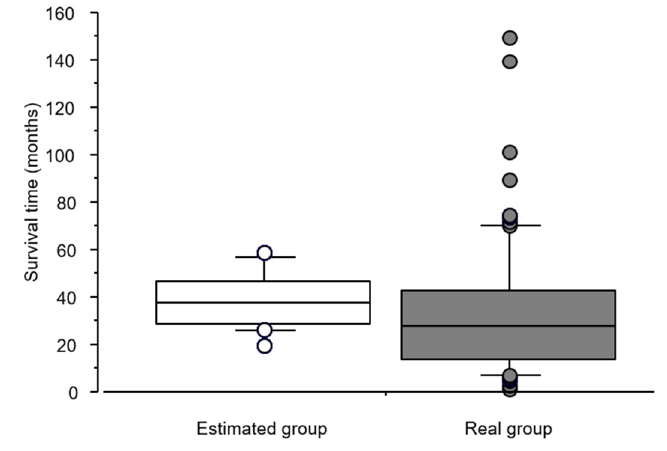
Figure 2. Boxplots of the estimated OS time and the real OS time in the validation cohort. The estimated survival time was calculated by the formula from the multiple linear regression analysis.